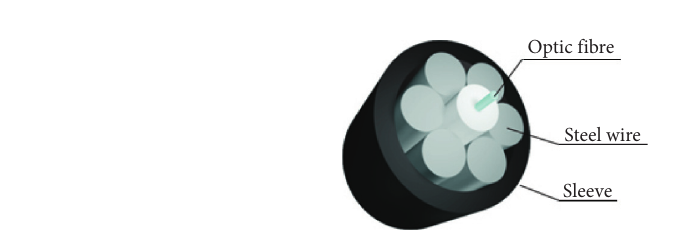
Figure 7: Internal structure of the optical